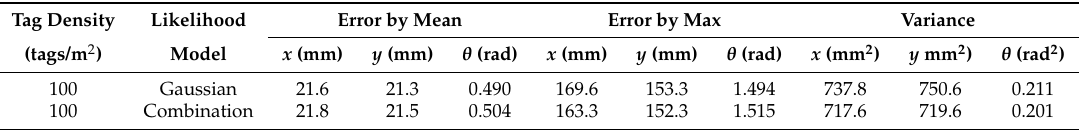
Table 3. Self-localization performances of the 96 HF-band RFID reader system without reinitialization.